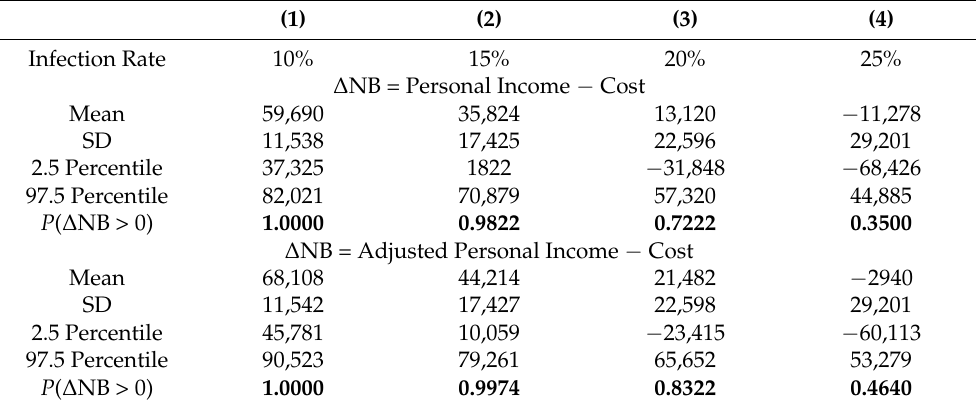
Table 4. Summary statistics (in dollars) of the ∆ NB distributions for New York.